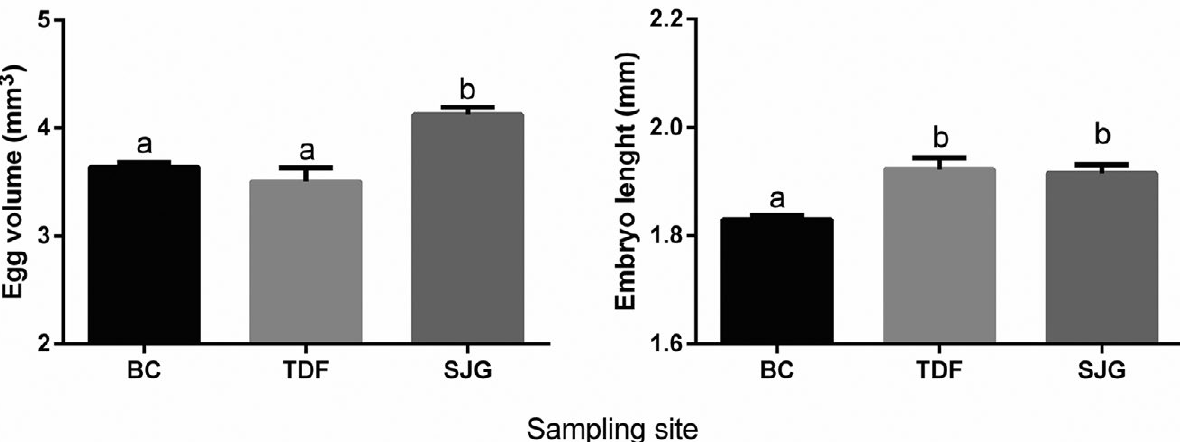
Fig. 6. – Egg volume (A) and embryo size (B) of L. santolla (mean±SE) from three sampling sites: Beagle Channel (BC), Tierra del Fuego (TDF) and San Jorge Gulf (SJG). Different letters indicate significant differences between sites (ANOVA, and Tukey,